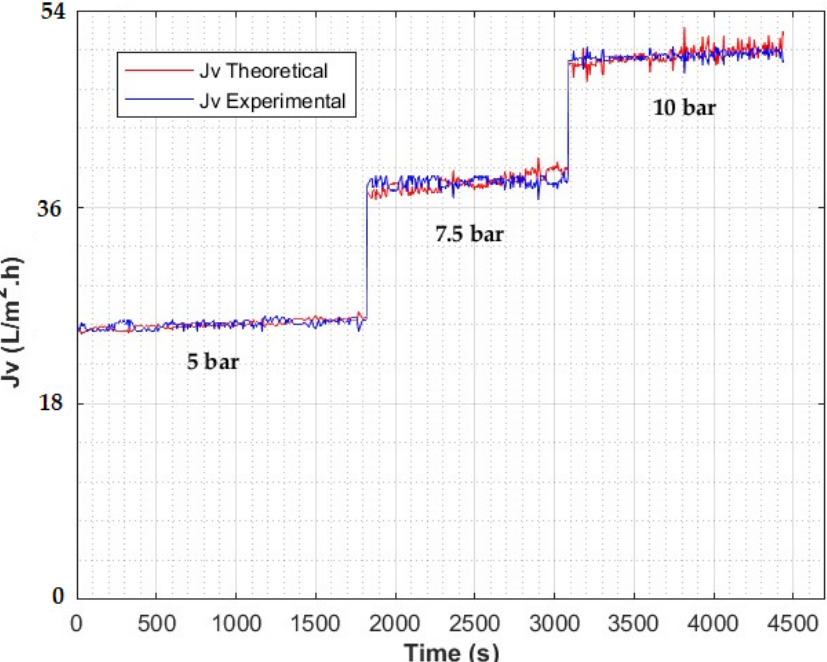
Figure 16. Theoretical vs. experimental flux of As: high concentration.